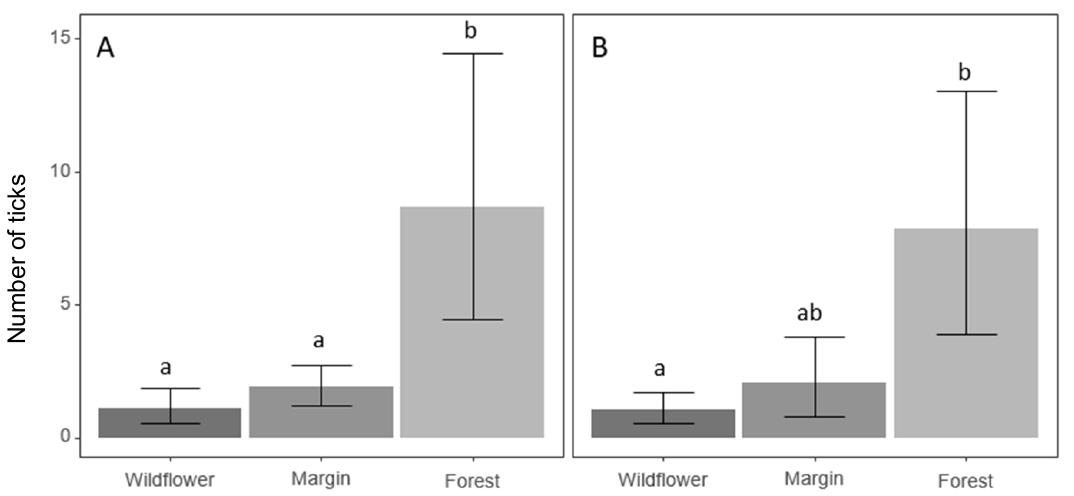
Figure 2. Average number of A. americanum sampled from each sampling habit in 2018 ( A ) and 2019 ( B ). Means with the same letter are not significantly di ff erent. (Tukey’s Honestly Significant Di ff erence) ( p < 0.05). Table 2. Yearly averages (mean ± std. error) of environmental factors measured at each sampling Table 3. Model selection for environmental variables a ff ecting the abundance of A. americanum adults. location. Models with interaction terms include the main e ff